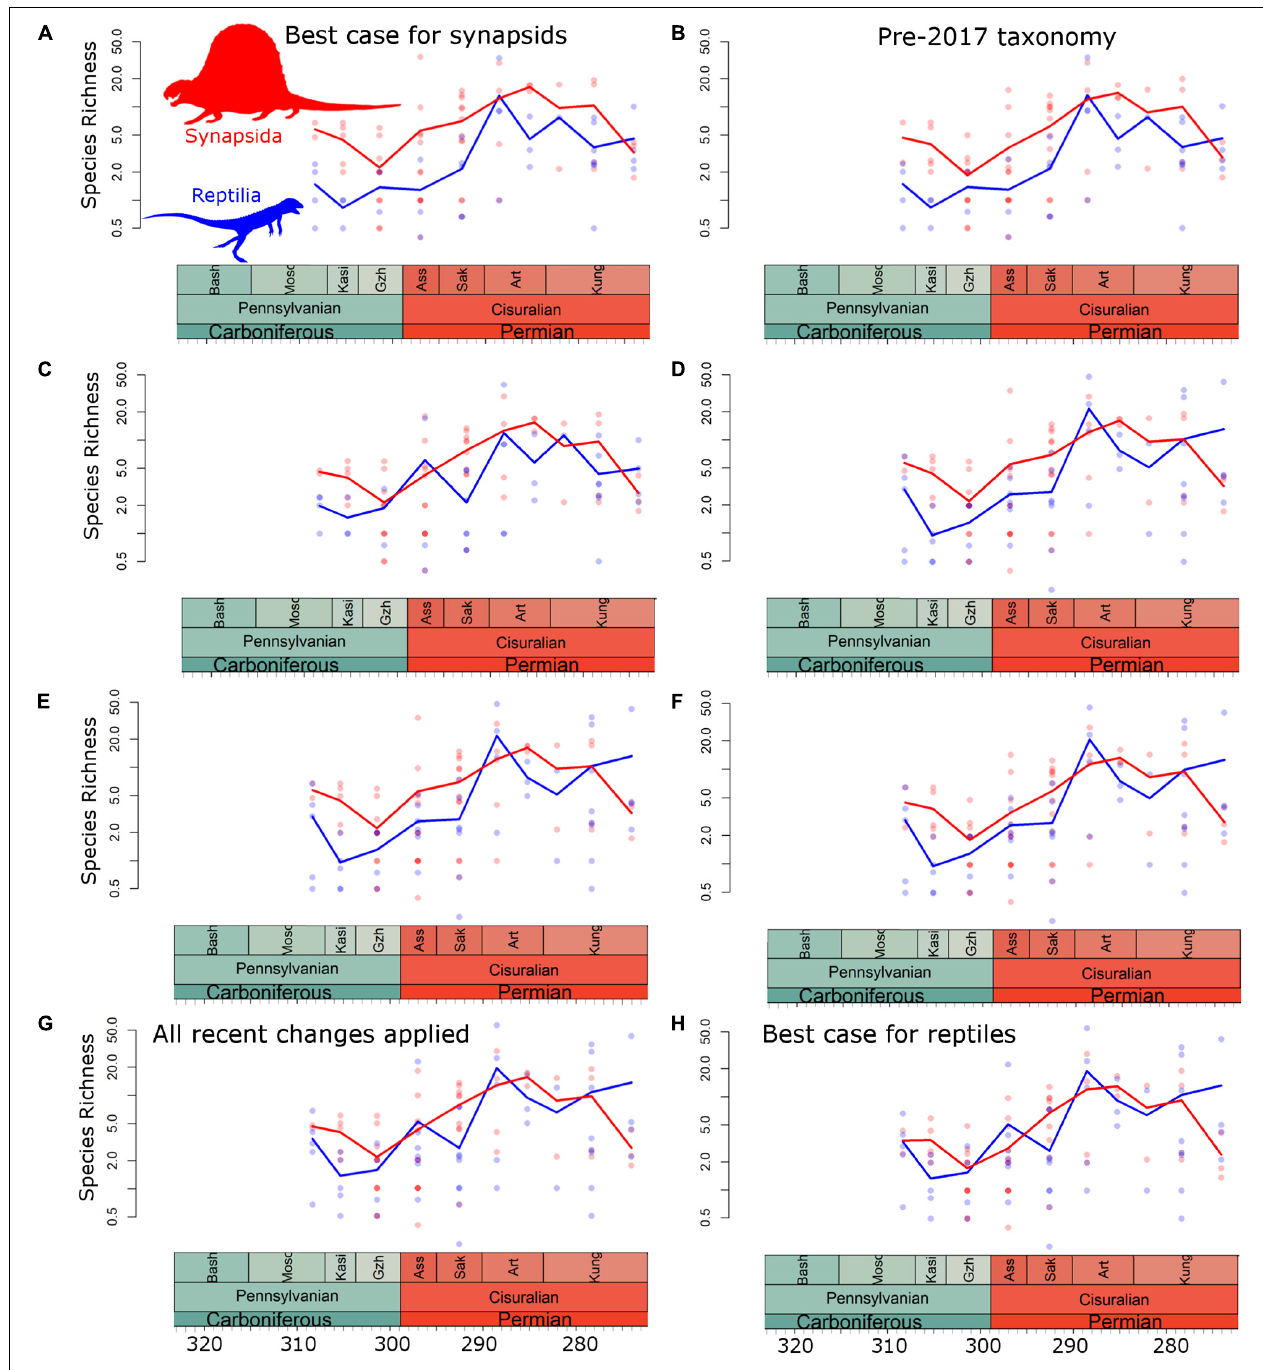
FIGURE 2 | Diversity estimates at the local scale. Points represent diversity within each bioregion (Blue = reptiles; Red = synapsids). Curve is median diversity within each time bin. (A) Taxonomic scheme 1; (B) Taxonomic scheme 2; (C) Taxonomic scheme 3; (D) Taxonomic scheme 4; (E) Taxonomic scheme 5; (F) Taxonomic scheme 6; (G) Taxonomic scheme 7; (H) Taxonomic scheme